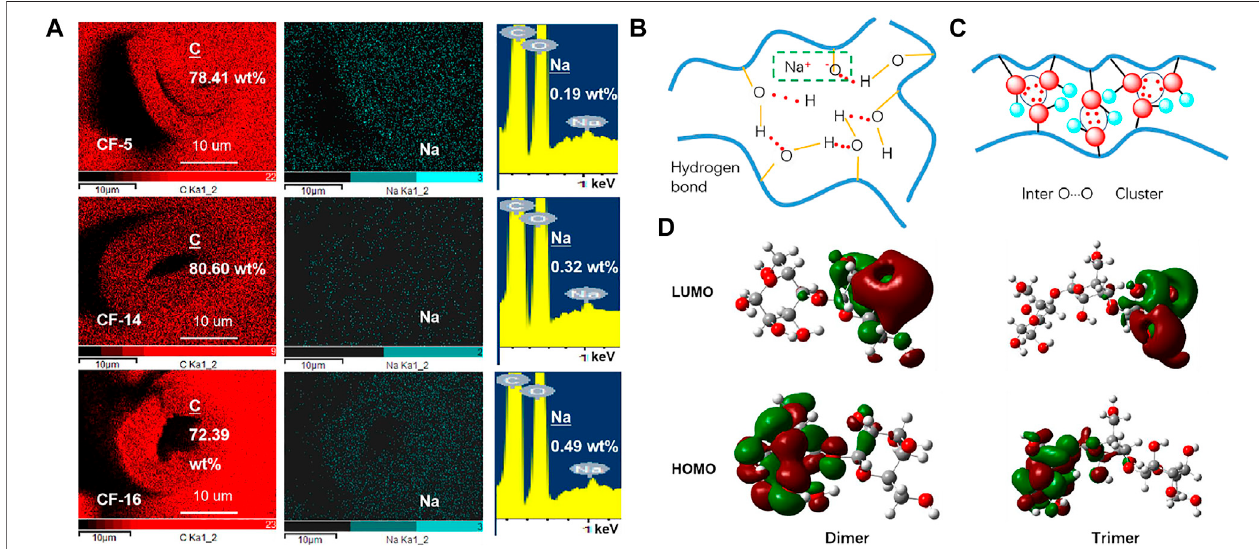
FIGURE 3| (A) SEM mapping images of CF cross-sections with different crystallinity (scale bar = 10 um), area scans ofC and Na elemental distribution. (B) Partial hydrogen bondinteractionsinCFs. (C) TheoxygenclustersinCFsaremainlyformedbytheinteraction ofoxygenatoms. (D) LUMOandHOMOelectron densities ofthe dimer and